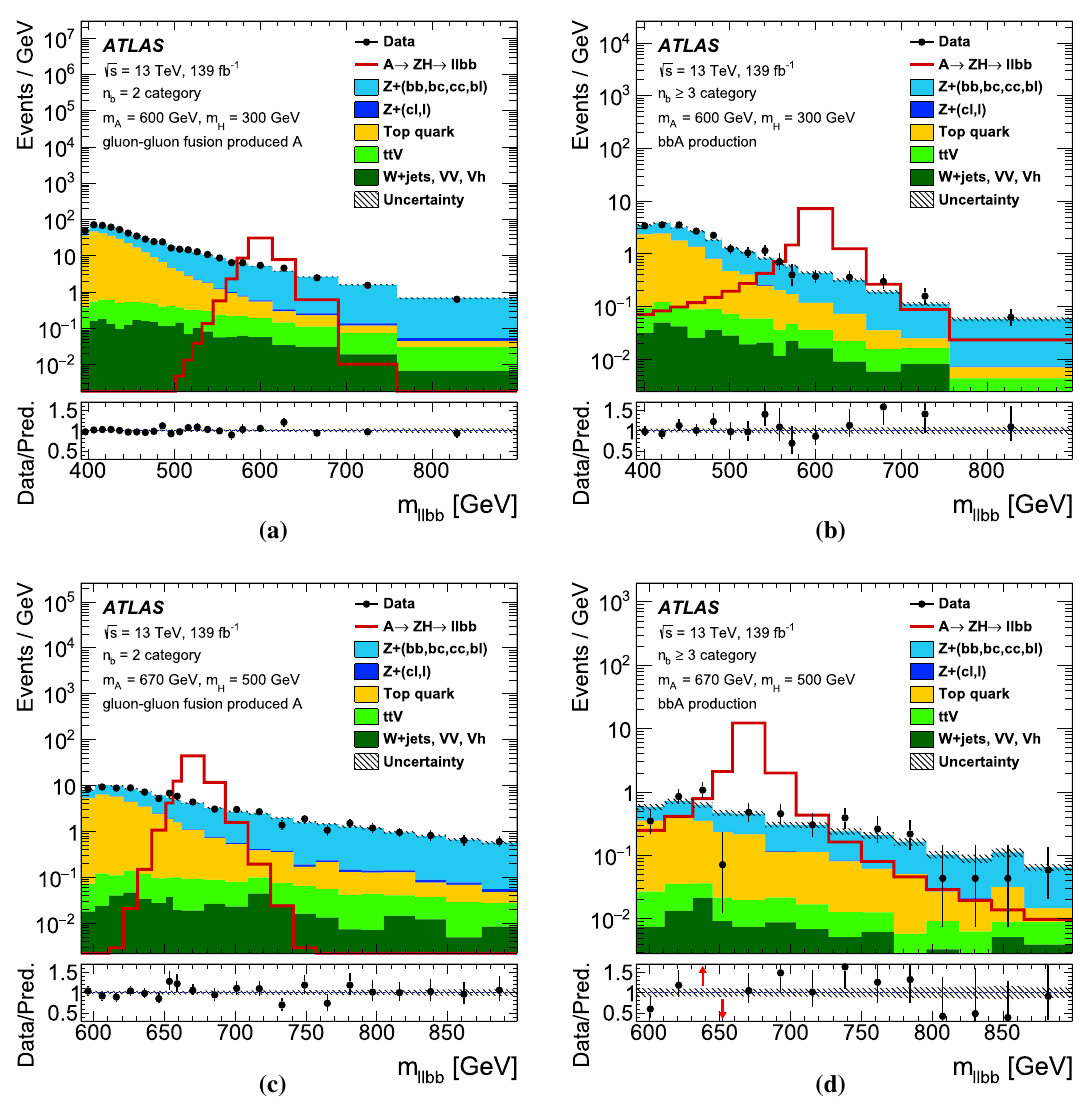
Fig. 8 The m (cid:6)(cid:6) bb mass distribution for the m bb windows defined also shown for gluon–gluon fusion production in ( a , c ) and b -associated for m H = 300 GeV and m H = 500 GeV for a , c the n b = 2 production in b , d . The number of entries shown in each bin is the num- and b , d the n b ≥ 3 category, respectively. Signal distributions with ber of events in that bin divided by the width of the bin. The same ( m , m ) = ( 600 , 300 ) GeV and ( m , m ) = ( 670 , 500 ) GeV are conventions as in Fig. 2 are A H A H